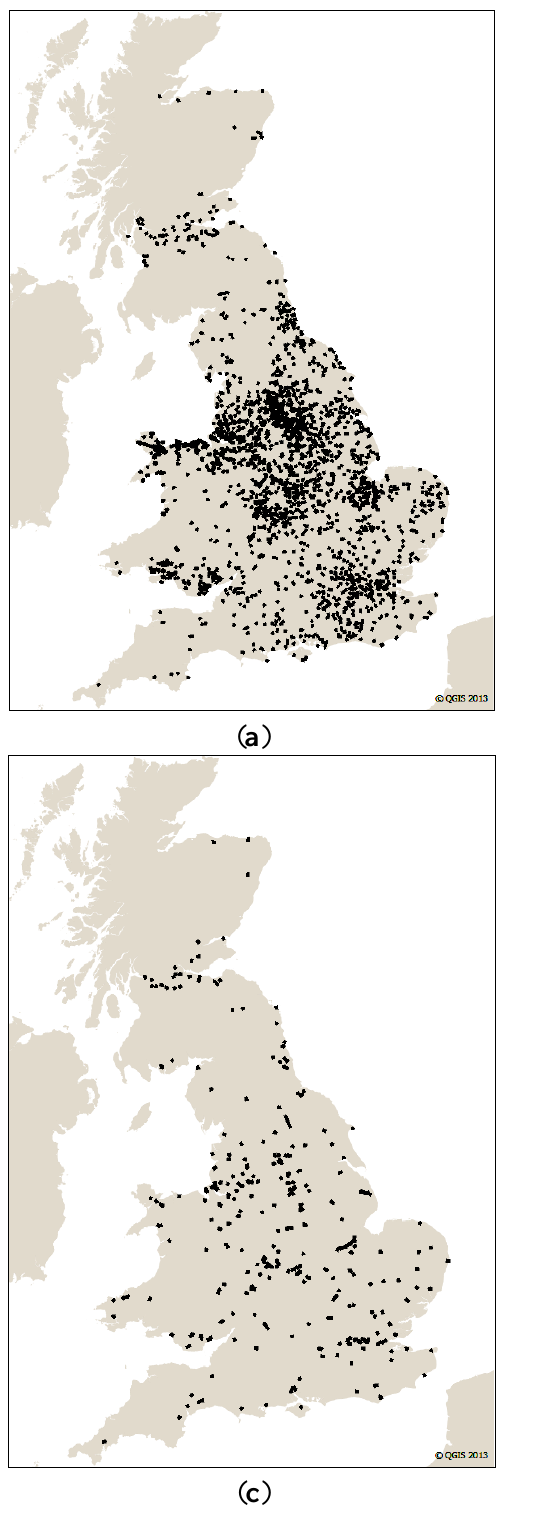
Figure 8. The geographical distribution of ( a ) Mismatched road names; ( b ) Missing road names; ( c ) Mismatched road references; ( d ) Missing road